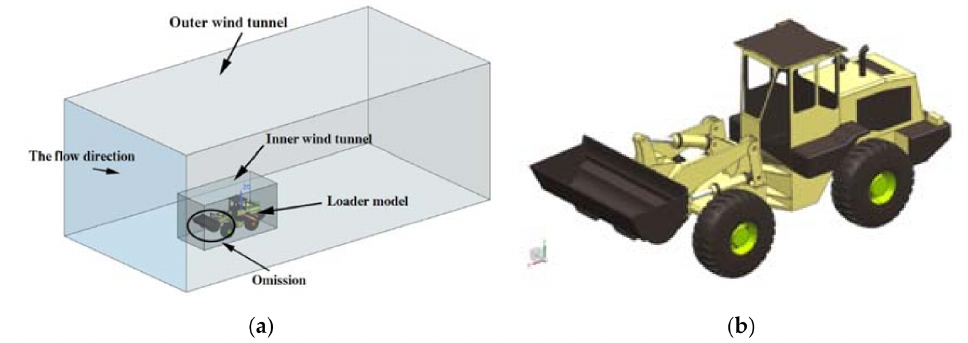
Figure 1. Virtual wind tunnel model. ( a ) The whole model; ( b ) the wheel